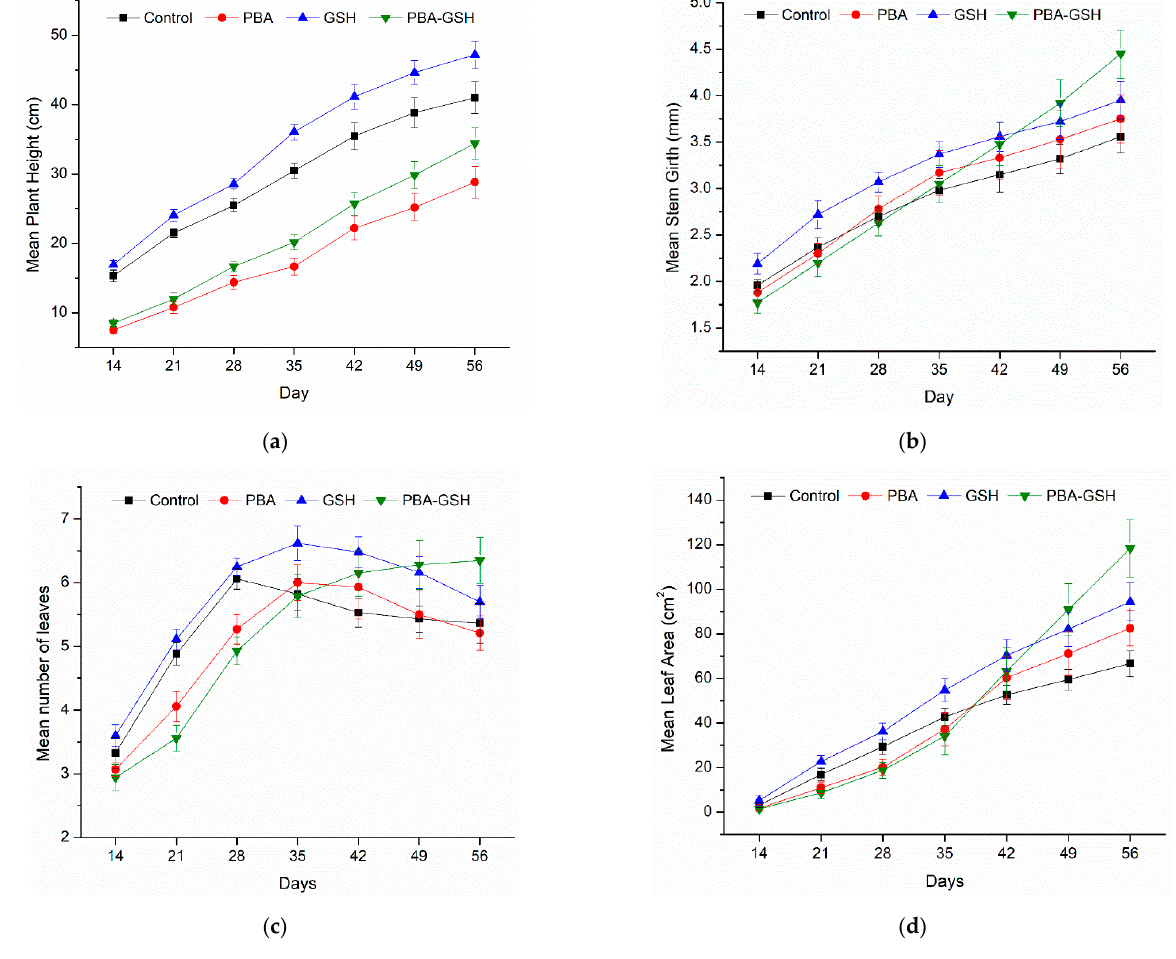
Figure 1. Graphs of plant growth parameters from different treatment groups with standard errors (n = 12) from day 14 till day 56. ( a ) Mean plant height; ( b ) Mean stem girth; ( c ) Mean number of leaves per plant; ( d ) Mean leaf surface area.